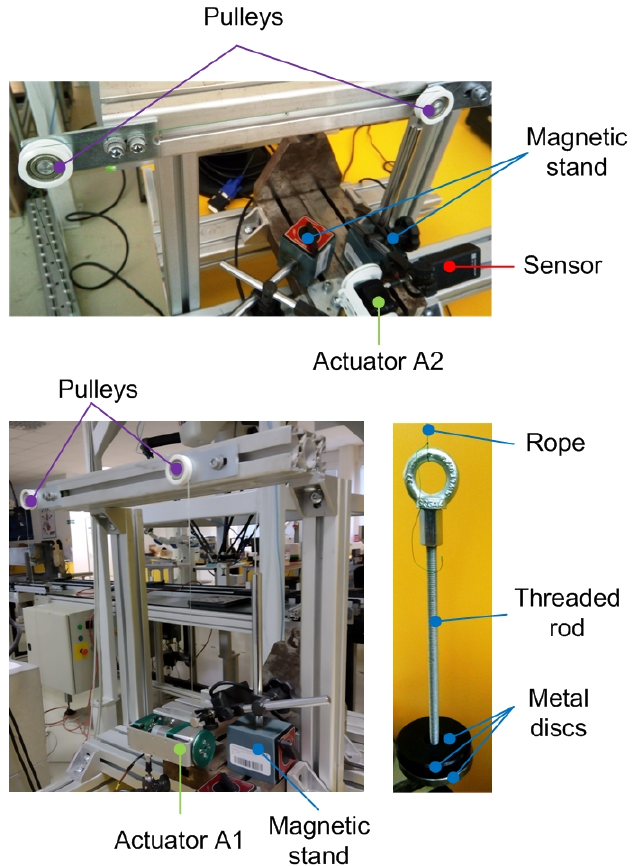
Figure 4. Placement of pulleys and weight.